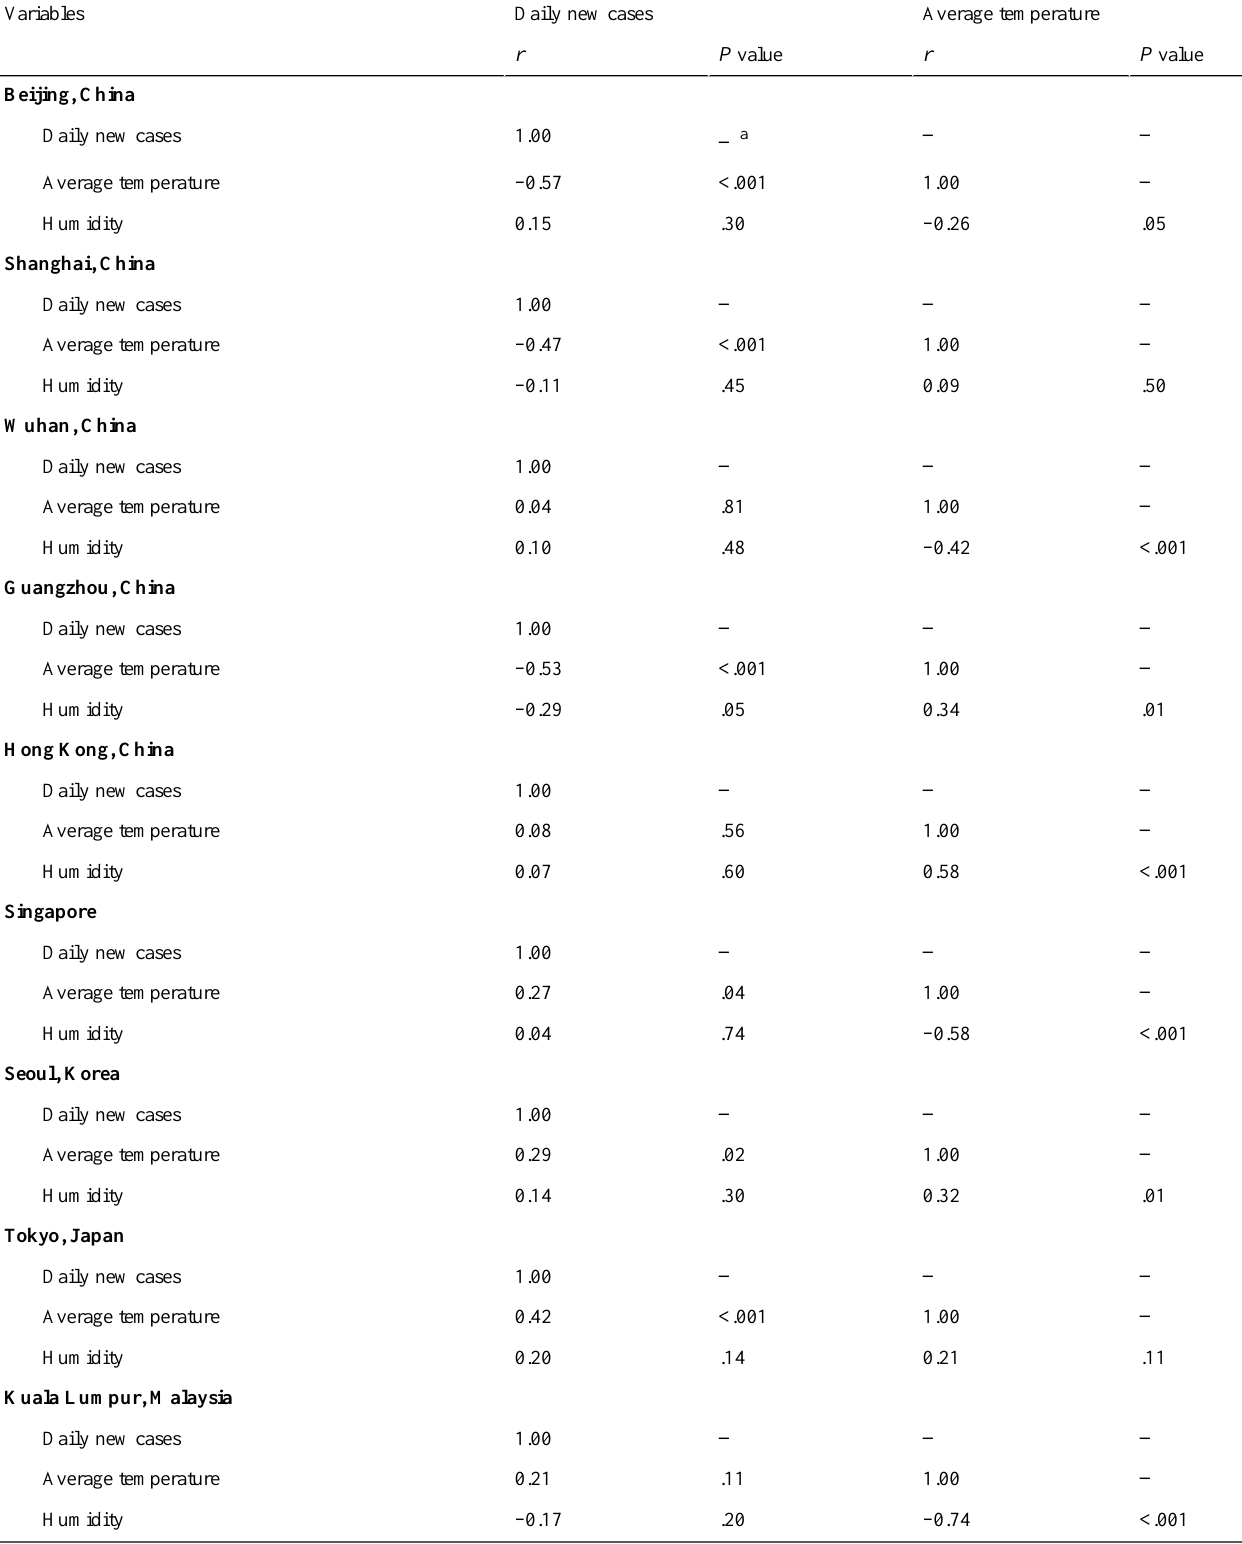
Table 3. Pearson correlation coefficient ( r ) between daily new COVID-19 cases and meteorological factors.